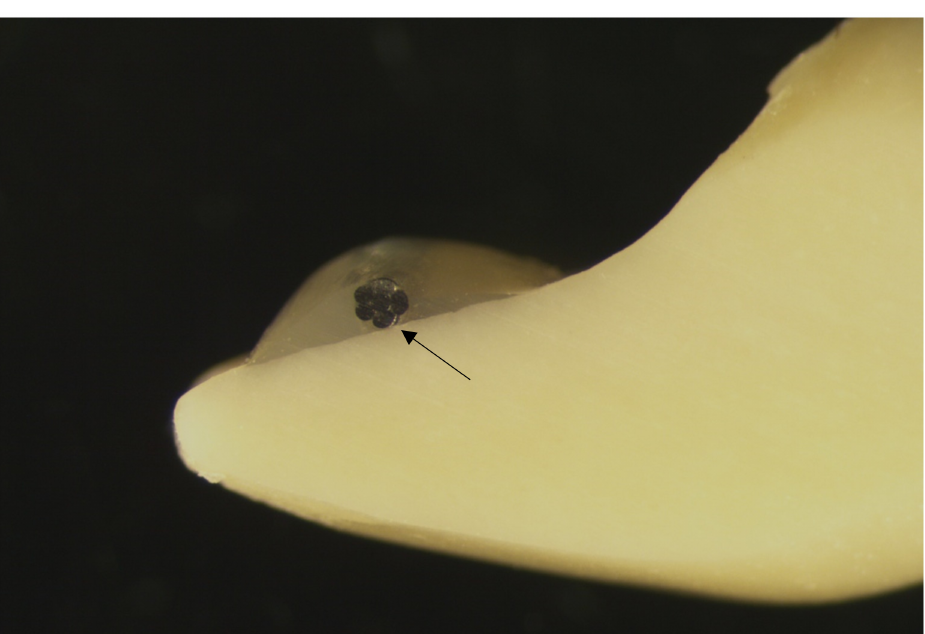
Figure 3. Photograph of the longitudinal section of a Frasaco tooth with Penta One 0.0215 and a flowable resin composite cover. The arrow points the place of the retainer.